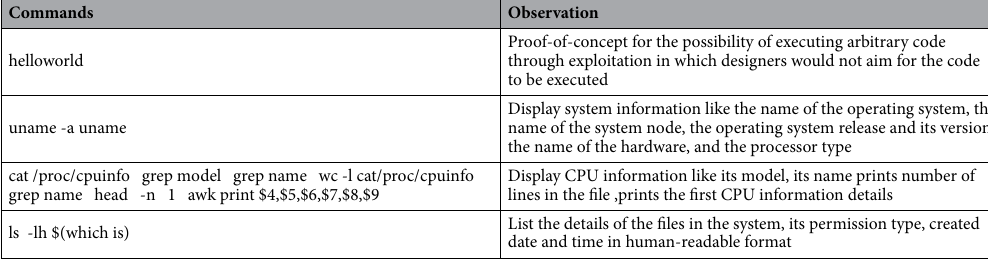
Table 1. Frequently utilized commands by the adversaries and their